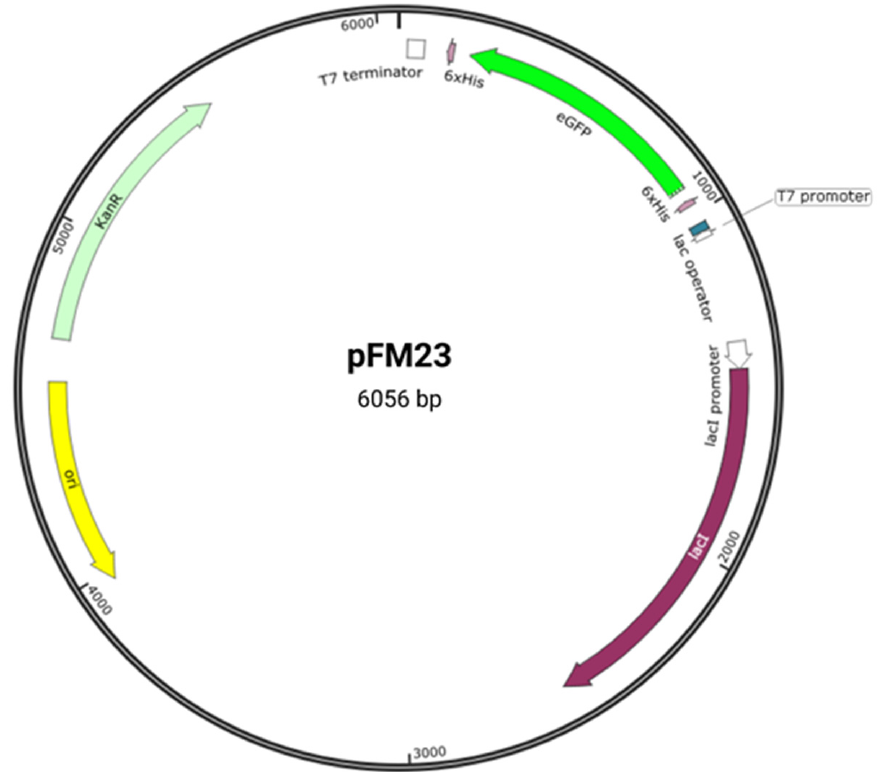
Figure 2. Plasmid pFM23 map. This harbours (i) a pMB1 origin of replication (ori), (ii) a repressor for the lac promoter (lacI), (iii) a transcriptional promoter from the T7 phage (T7 promoter), (iv) a lactose operator (lac operator), (v) an affinity purification tag (6 × His), (vi) a T7 transcriptional terminator (T7 terminator), (vii) a kanamycin resistance gene (KanR), and (viii) the eGFP gene